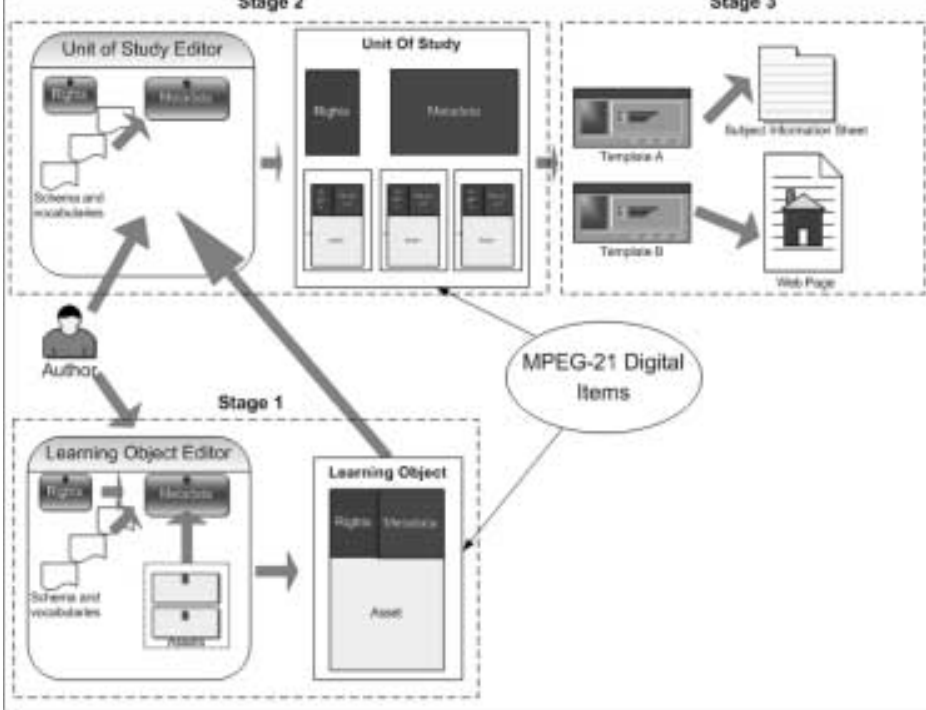
Figure 1. Overview of the SLDF